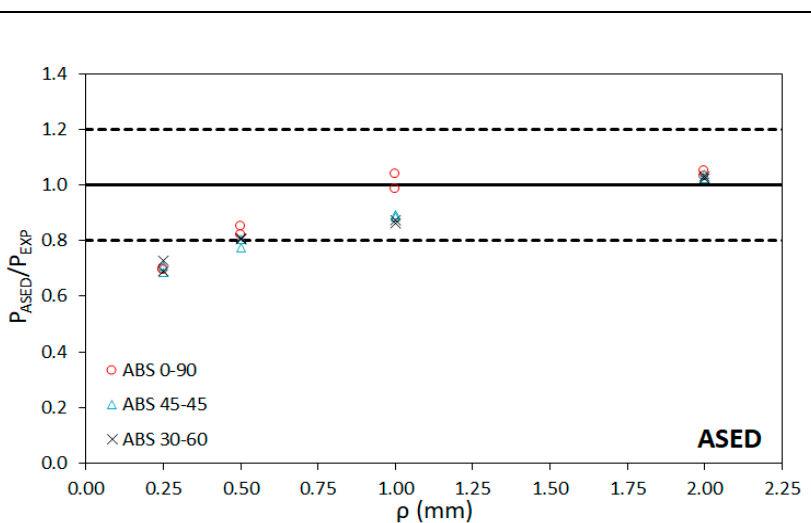
Figure 7. Comparison between fracture load predictions using ASED and experimental fracture loads.